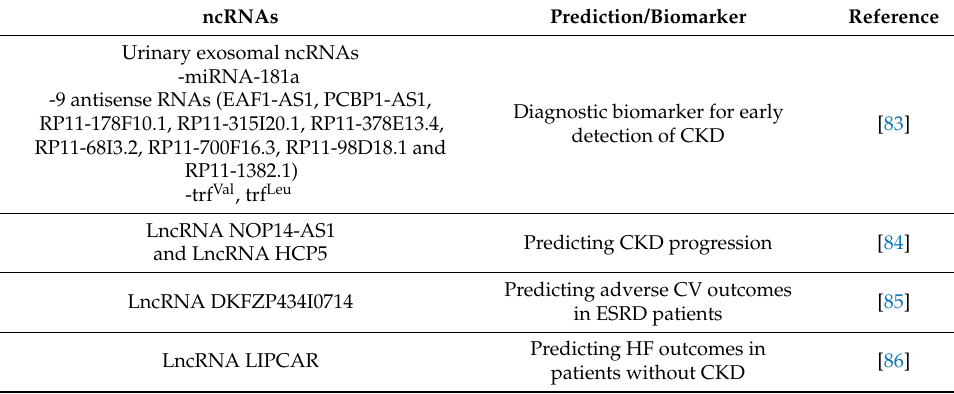
Table 2. Representative ncRNAs as prognostic